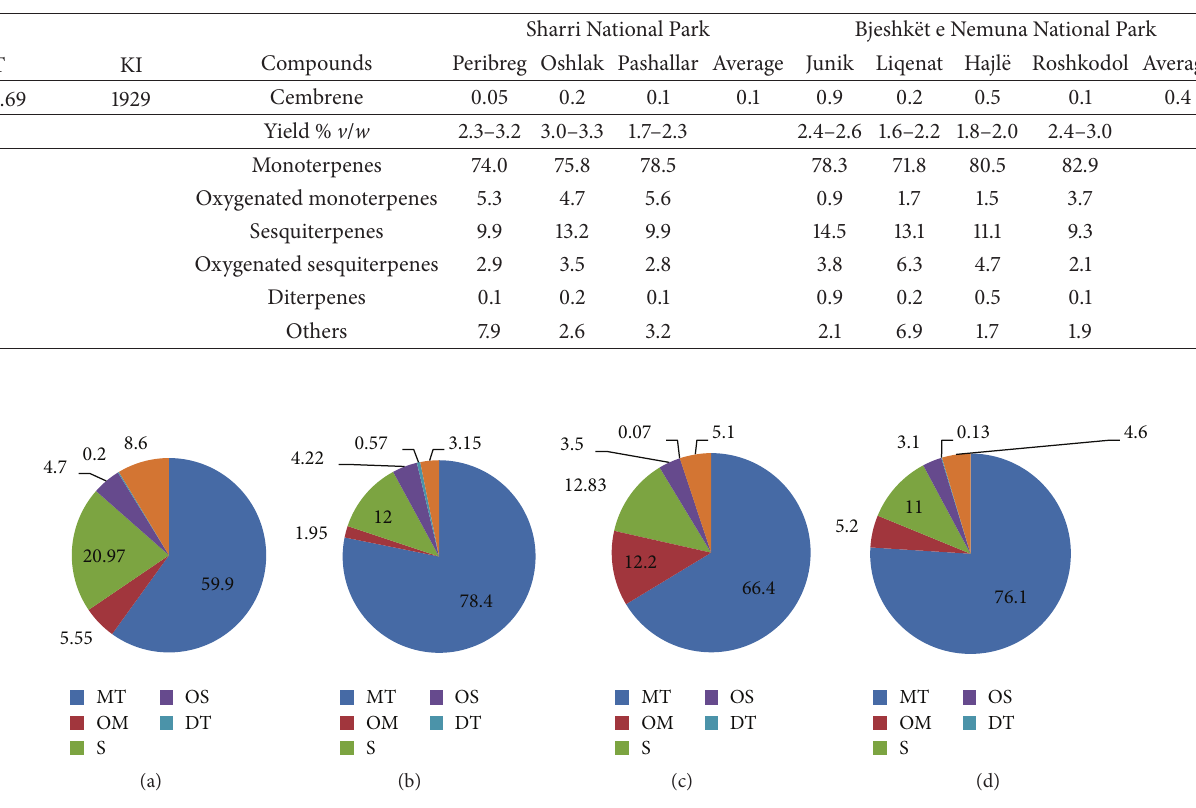
Figure 1: Average concentrations of essential oil constituents obtained from needles (a) and twigs (b) of Pinus peuce from Bjeshk¨et e Nemuna National Park, and needles (c) and twigs (d) from Sharri National Park. MT: monoterpenes; OM: oxygenated diterpenes; S: sesquiterpenes; OS: oxygenated sesquiterpenes; DT: diterpenes. OC: other